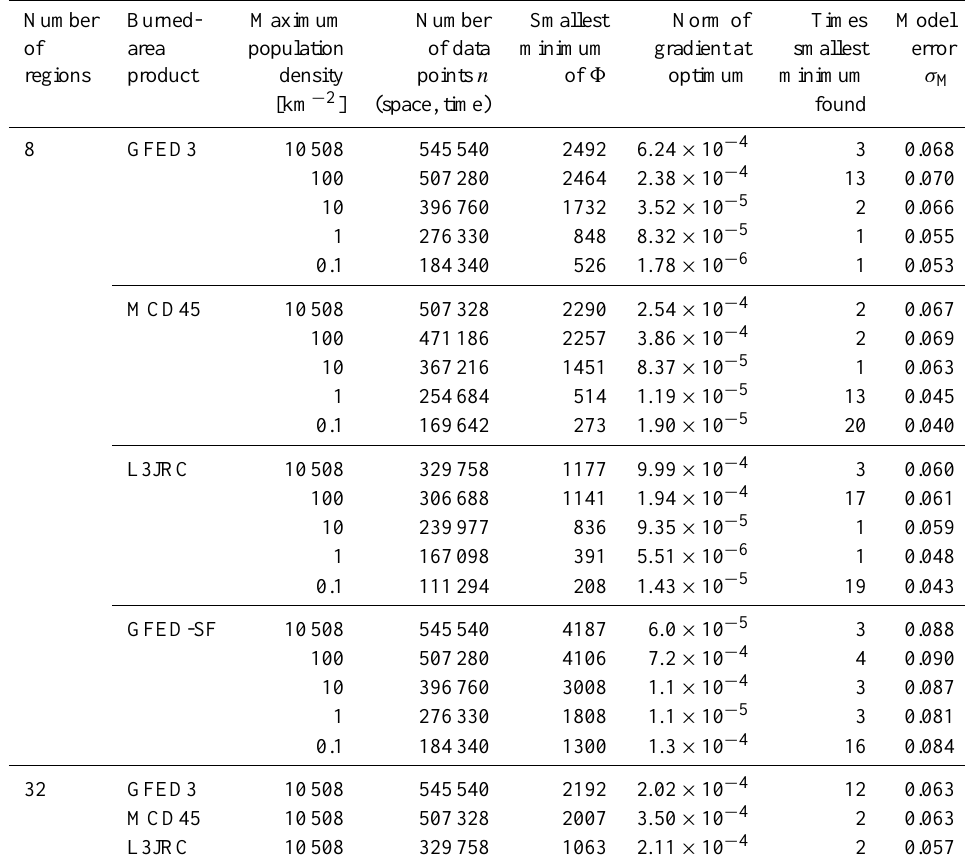
Table 1. Summary of optimisations. Number Burned- Maximum Number Smallest Norm of Times Model of area population of data minimum gradient at smallest error regions product density points